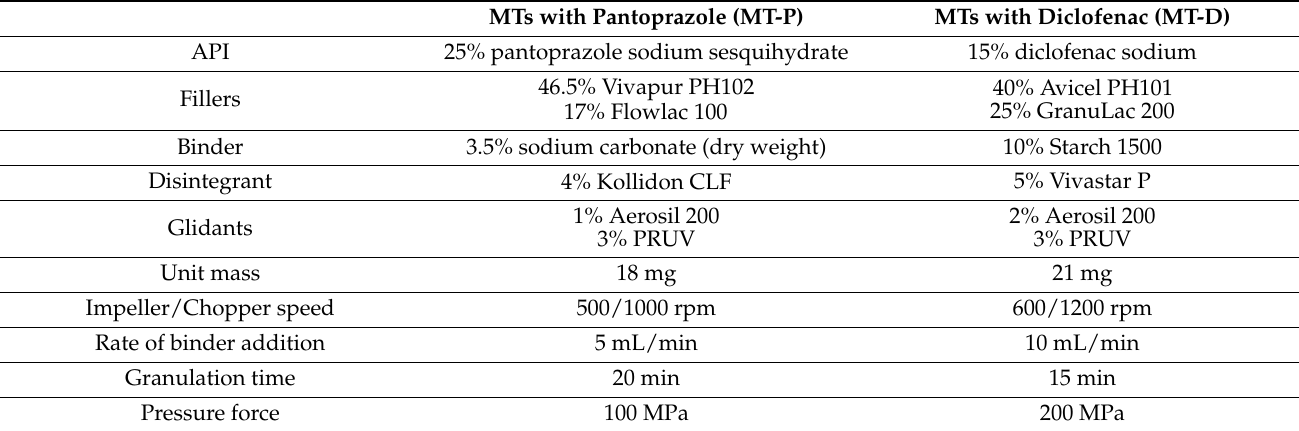
Table 1. Characteristics of MT cores and process